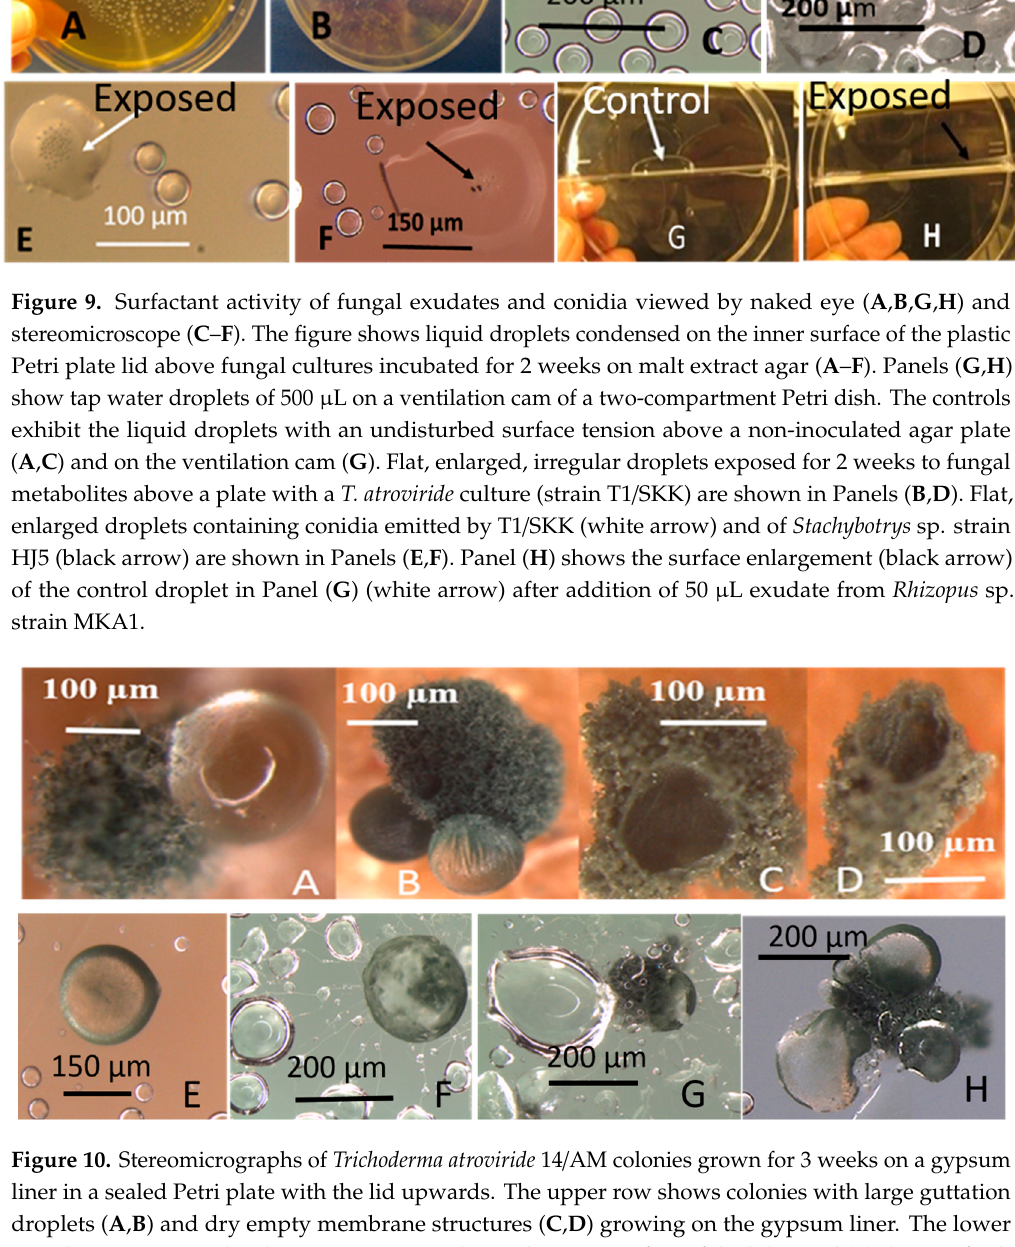
Figure 10. Stereomicrographs of Trichoderma atroviride 14/AM colonies grown for 3 weeks on a gypsum liner in a sealed Petri plate with the lid upwards. The upper row shows colonies with large guttation droplets ( A , B ) and dry empty membrane structures ( C , D ) growing on the gypsum liner. The lower row shows guttation droplets containing conidia on the inner surface of the lid. Panel ( E )